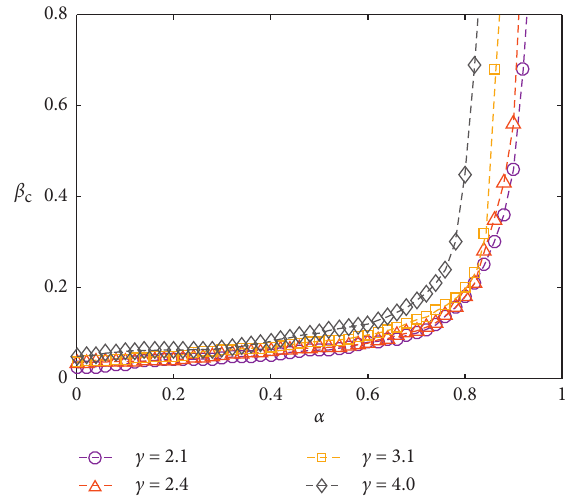
Figure 6: The relationship between the epidemic threshold β the instinctive self-awareness α when the degree exponents are set at c � 2 . 1 (purple circles), c � 2 . 4 (red triangles), c � 3 . 1 (yellow squares,) and c � 4 . 0 (gray rhombuses), respectively. The other parameters are the same as those in Figure 1. Data are obtained by averaging over 10 2 × 10 2 independent realizations on 10 2 networks.